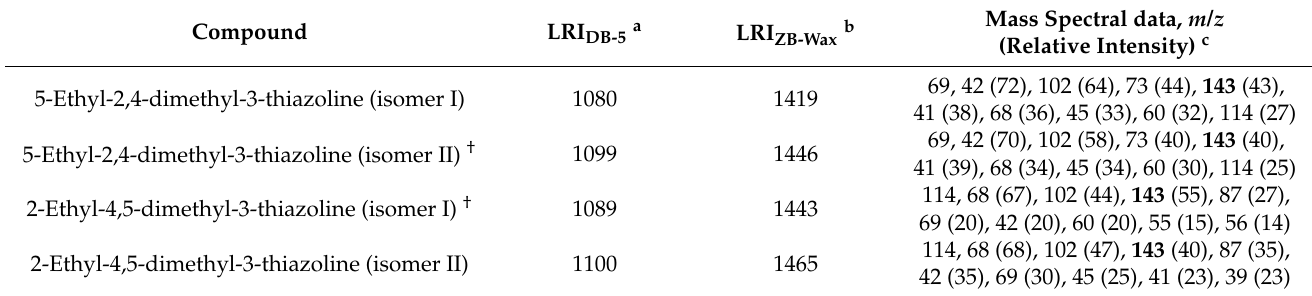
Table 3. Mass spectral data for 5-ethyl-2,4-dimethyl-3-thiazoline and